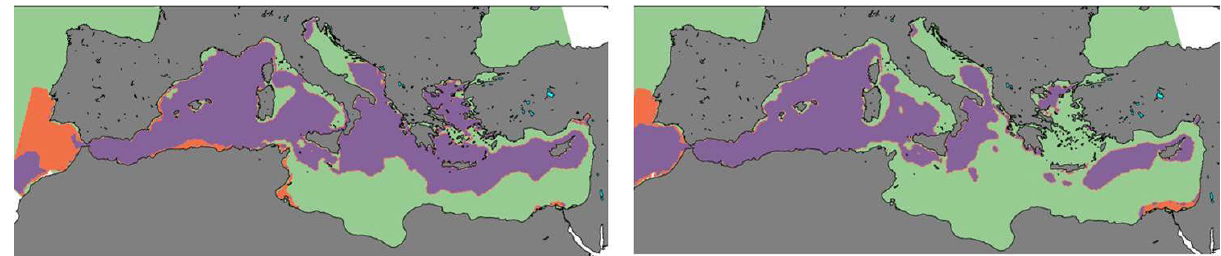
Figure 12. Present (1980–1999) and future (2080–2099) interannual average surface (0–200m) limiting nutrient in the HIS/A2 simulation. N and P co-limitation is considered when limitation factors for N and P differ by less than 1%. Green zones are P limited, orange zones are N limited, and purple zones are N and P